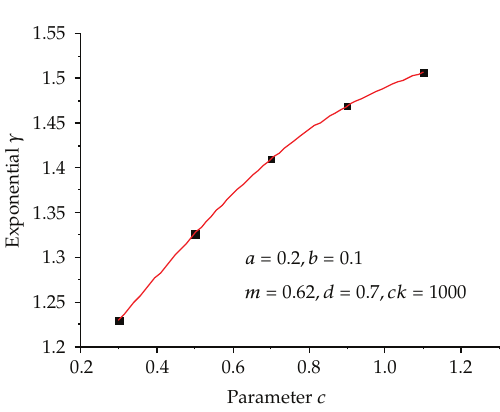
Figure 4: E ff ect of parameter c on power exponent γ .